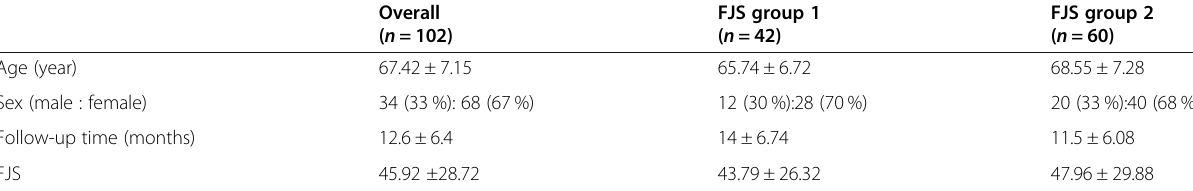
Table 2 Demographics of 102 patients (Group 1 did not receive a second call; group 2 received a second call.)